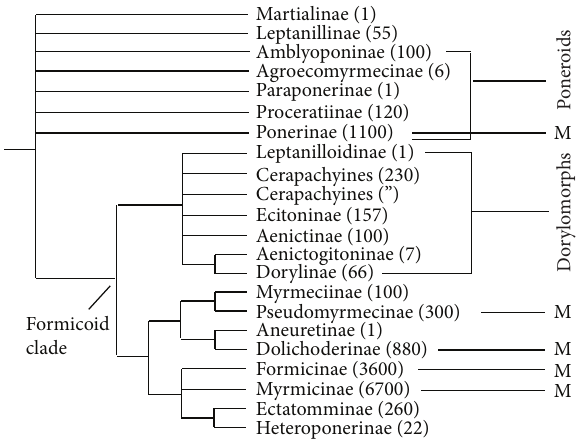
Figure 2: Phylogenetic tree summarizing well-supported relation- ships between extant subfamilies of ants (modified from [31]), with indication of known associations with Microdontinae (“M”). Numbers in parentheses are estimated numbers of described species per subfamily (based on [27,